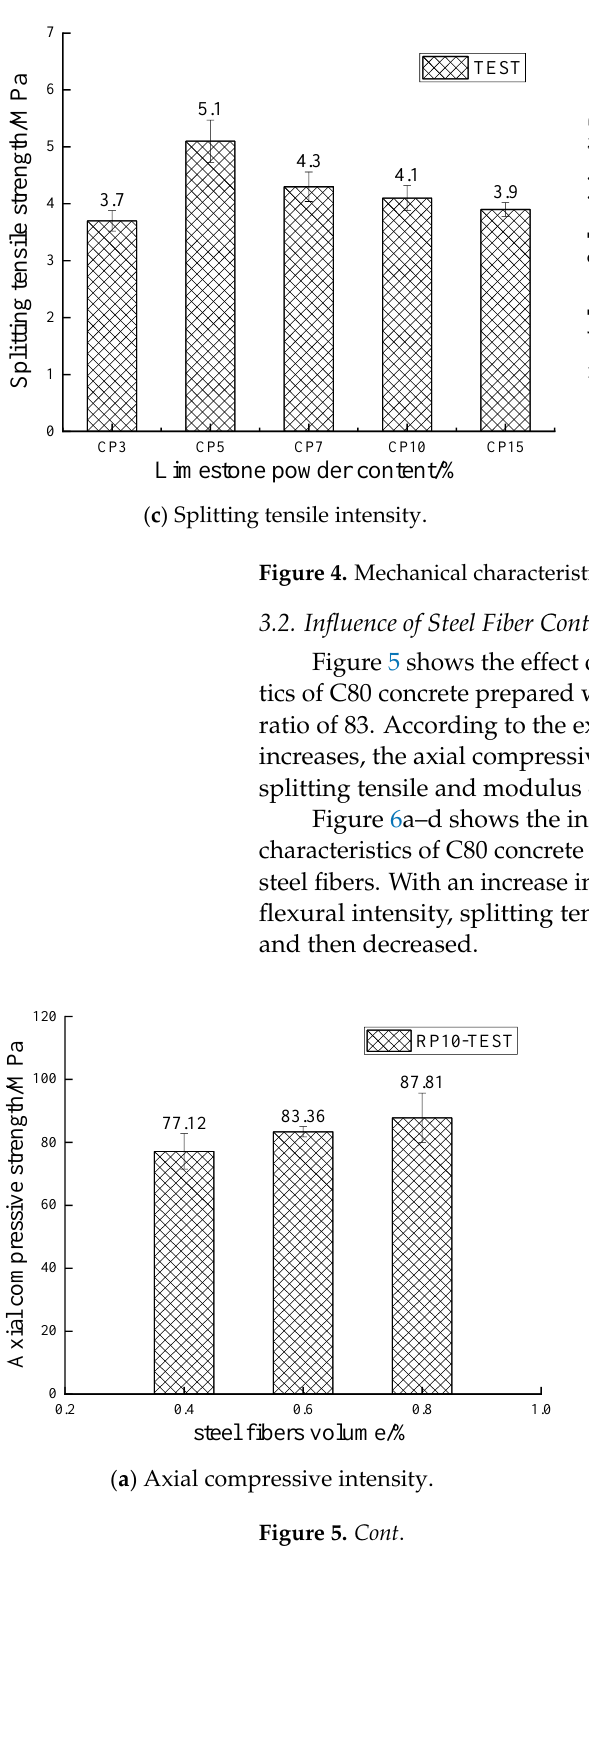
( d ) Elastic modulus. Figure 5. Mechanical characteristics of concrete with 10% LP incorporating different steel fiber GSF0325 contents. Figure 6a – d shows the influence of the aspect ratios of steel fibers on the mechanical characteristics of C80 concrete prepared with 15% of LP content and a constant 0.4 vol.% of steel fibers. With an increase in the steel fibers ’ aspect ratio, the axial compressive strength, flexural intensity, splitting tensile and modulus of elasticity were first slightly increased and then decreased. In general, the increase in the amount of steel fibers can not only increase the flexural intensity and ductility of concrete, but can also increase the axial compressive intensity, which could be the reason that the high LP content padded the gap resulting from the addition of steel fibers. Note that when analyzing these experimental data, the arithmetic average value has obvious discreteness (i.e., different standard deviations) and it is hard to confirm the steel fiber content and its type for compensating for the mechanical characteristics of concrete with 10% and 15% LP values.